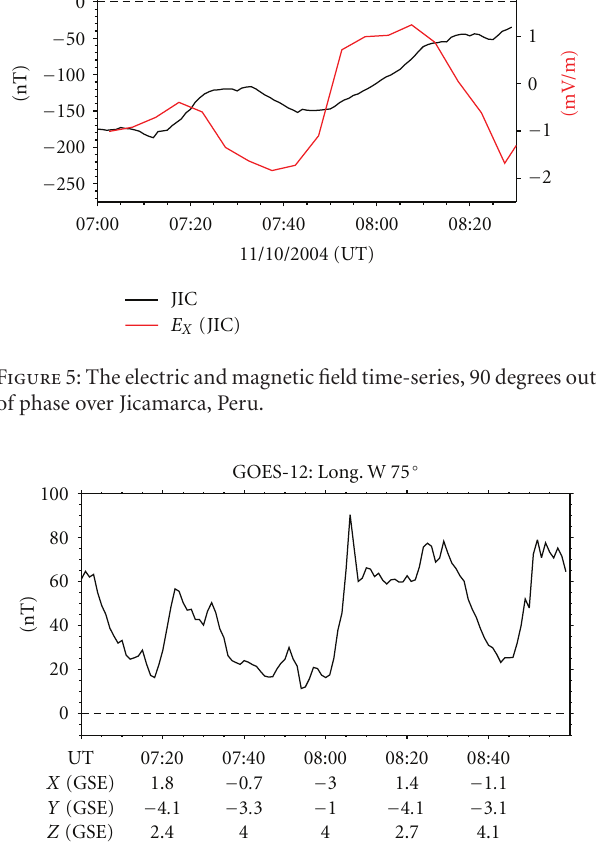
Figure 6: The GOES-12 (Long. W 75) parallel component of the magnetic field versus universal time (UT) and GSE coordinates.